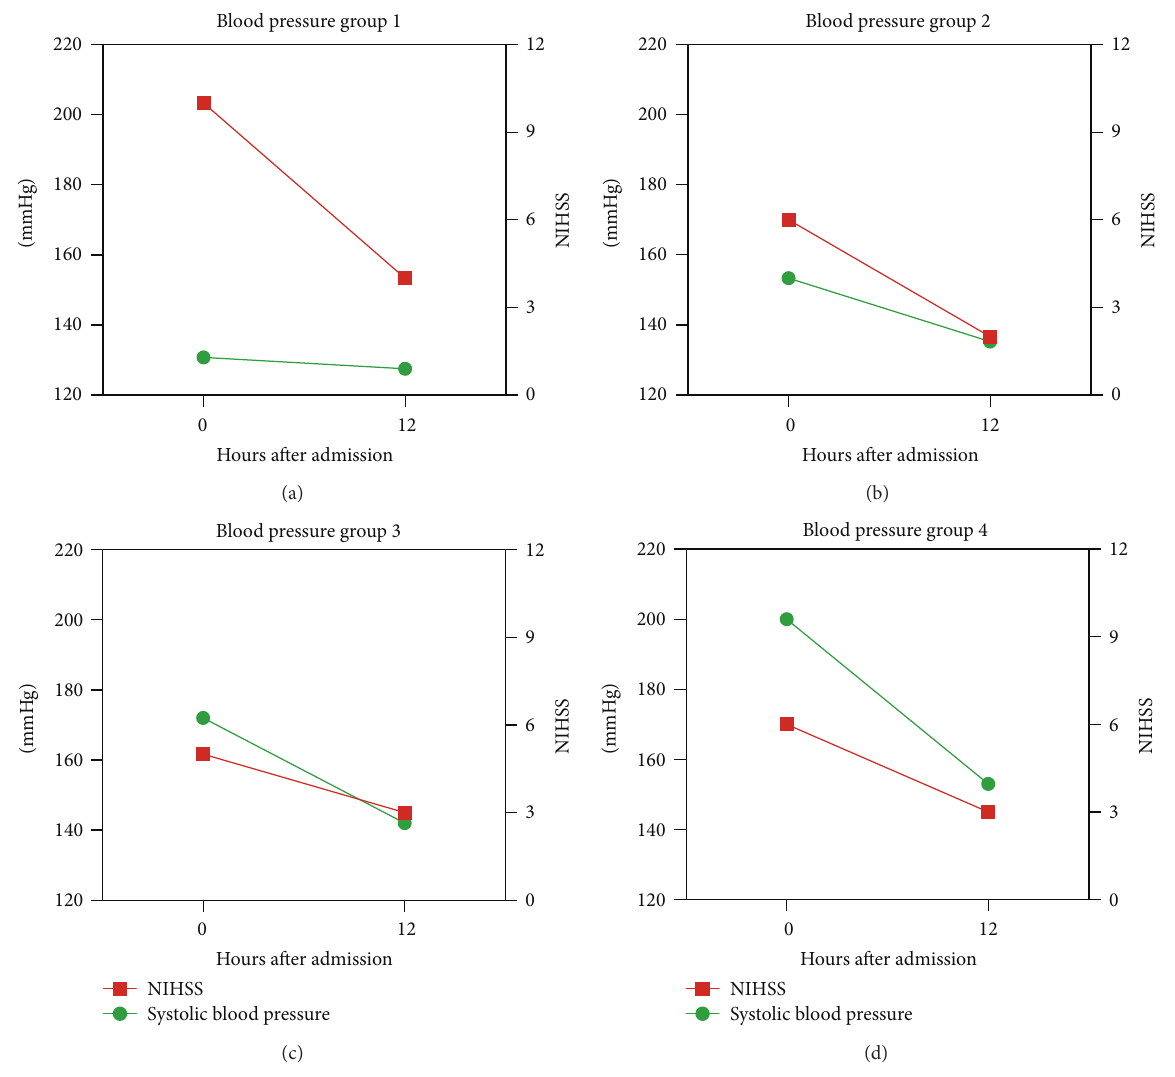
Figure 3: The association between NIHSS after tPA, representing short-term outcome, and the development in the systolic blood pressure groups within the first 12 hours after admission.